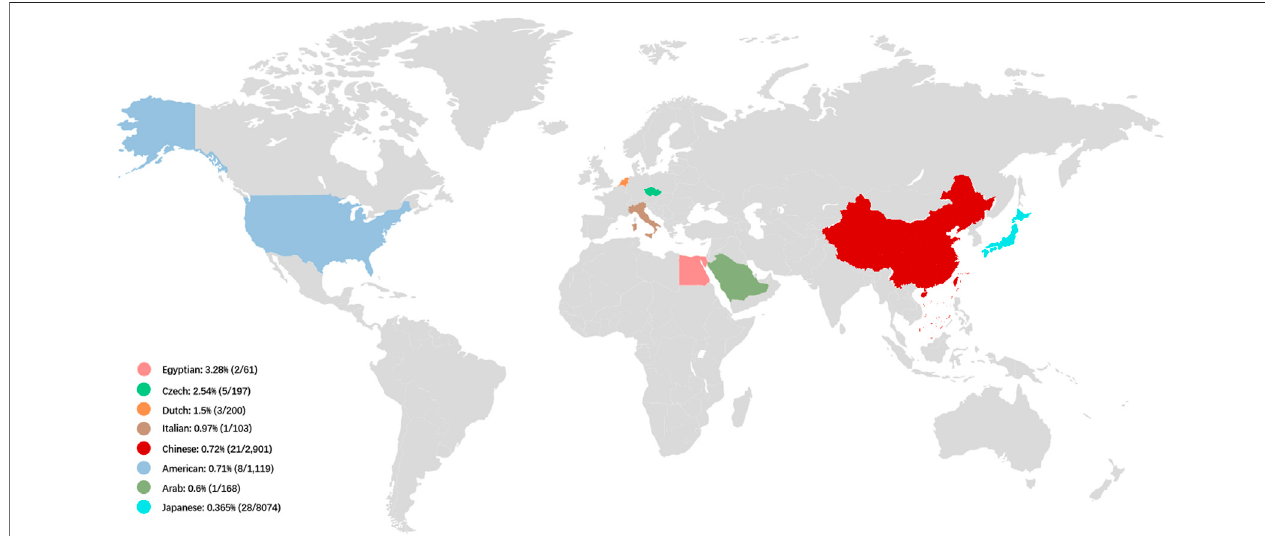
FIGURE2 | The prevalence of LOXHD1 -associated HL inNSHL cohorts indifferentcountries.The prevalence of LOXHD1 -associated HL in NSHLcohorts ranged rom 0.365 to 3.28% in the seven countries (Egypt, Czech, Netherlands, Italy, China, United States, Arab and